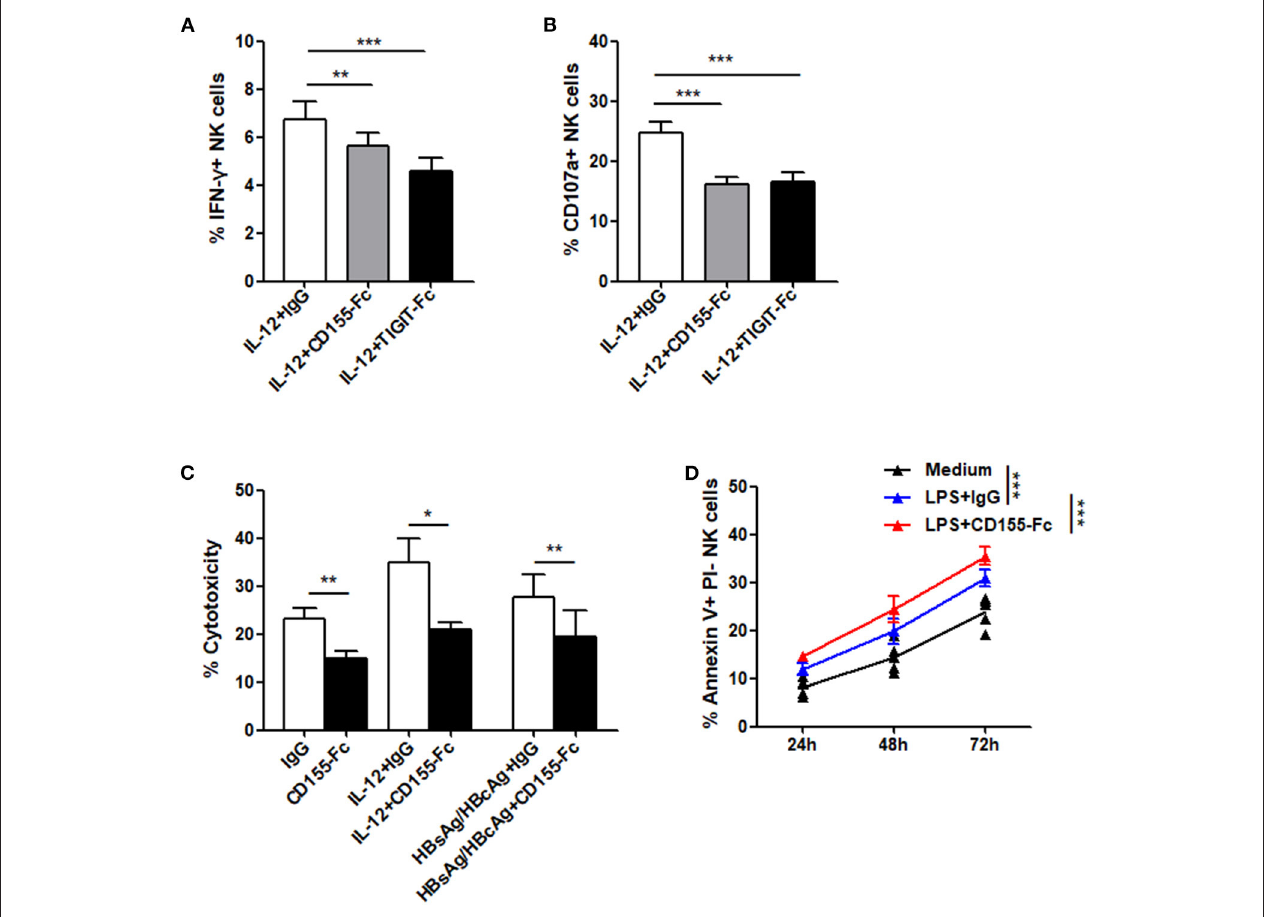
FIGURE 5 | (A–C) PBMCs isolated from CHB-IA were stimulated with IL-12 or specific stimulants (recombinant HBsAg protein or recombinant HBsAg and HBcAg protein mixture) in the (A,D) absence or (B,C) presence of CD155Fc or TIGIT Fc protein or IgG control for 24h. The percentages of (A) IFN- γ and (B) CD107a in NK cells before and after stimulation were evaluated by flow cytometry. (C) K562 cells labeled with CFSE were used as target cells. E:T ratios was 1:10 for 6h. Representative FACS plots showing cytotoxicity of NK cells. The cytotoxicity of NK cells inCHB-IA was analyzed and shown as the mean ± SD (n = 5). (D) PBMCs isolated from CHB-IA were stimulated with LPS in the absence or presence of CD155Fc or IgG control or 24, 48, and 72h. The percentages of Annexin V + PI- NK cells was measured by flow cytometry. Data are from a single experiment representative of three. * p < 0.05, ** p < 0.01, *** p <